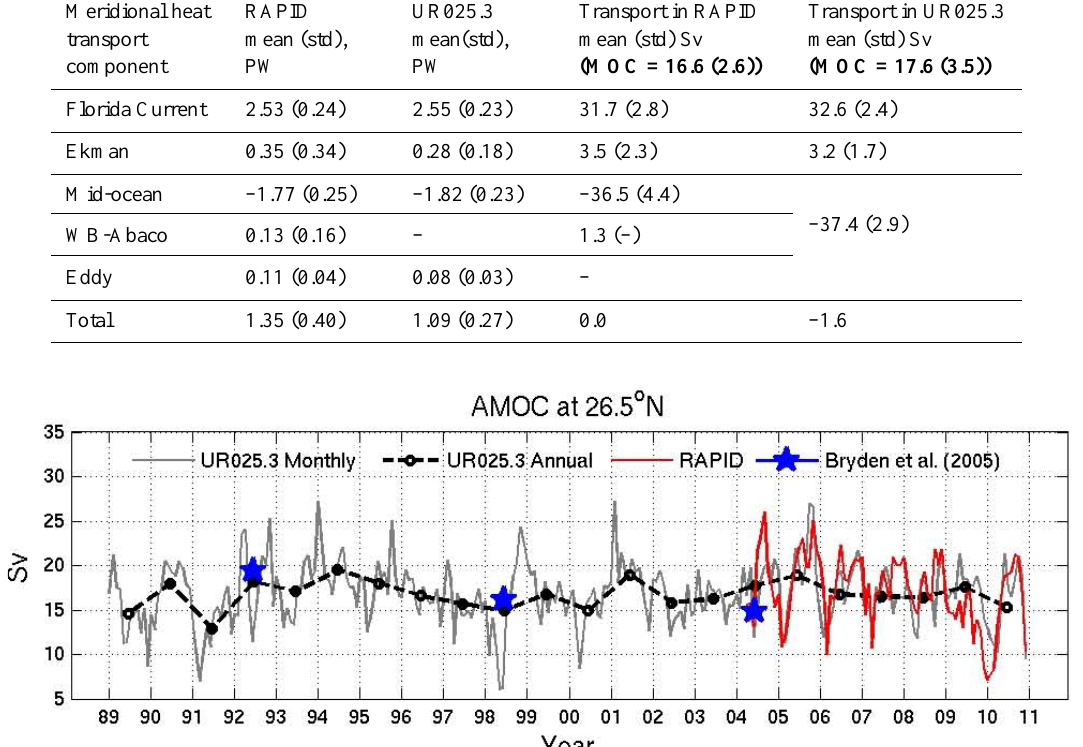
Table 2. Decomposition of the Atlantic 26N meridional heat transport in UR025.3 over the 3.5-year period Apr 2004–Oct 2007, compared with Johns et al. (2011) RAPID estimates for the same period, along with the meridional overturning components. Note that the UR025.4 Mid-ocean heat transport includes all transport east of the Bahamas, including Abaco. Corresponding standard deviations are given in round brackets. For the full 2004–2010 period, the RAPID MOC is 18.6 (3.7) Sv and UR025.3 MOC is 17.3 (3.3) Sv.